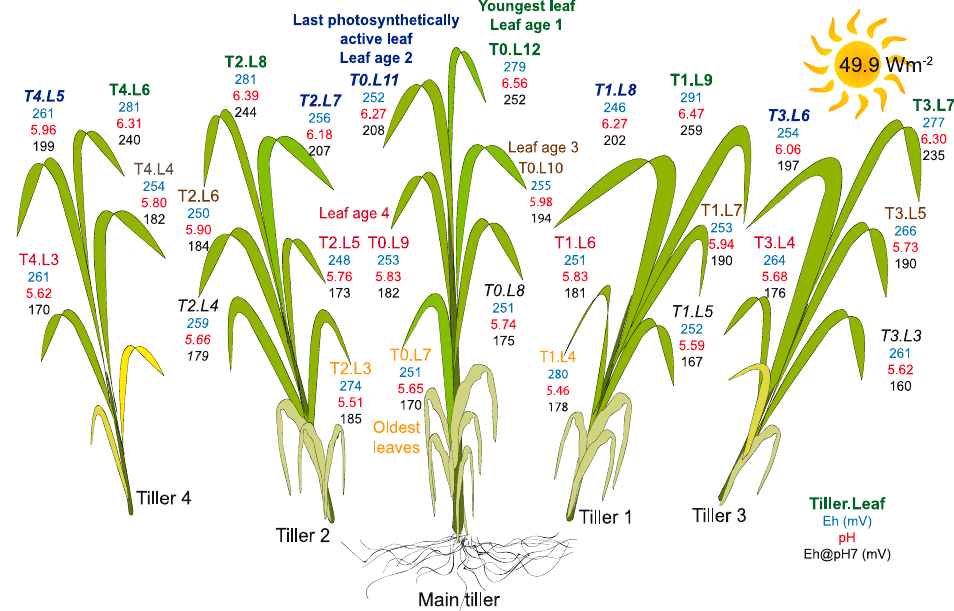
Figure 5. Map of inter-leaf variability in pH, Eh and Eh@pH7 over tillers and leaf ranks. Leaf and tiller numbering according to Katayama (1951). Data are means ( n = 4) of the middle part of the leaf of four 61 to 64-day-old plants from season II, sown 17 August 2016 under upland management.